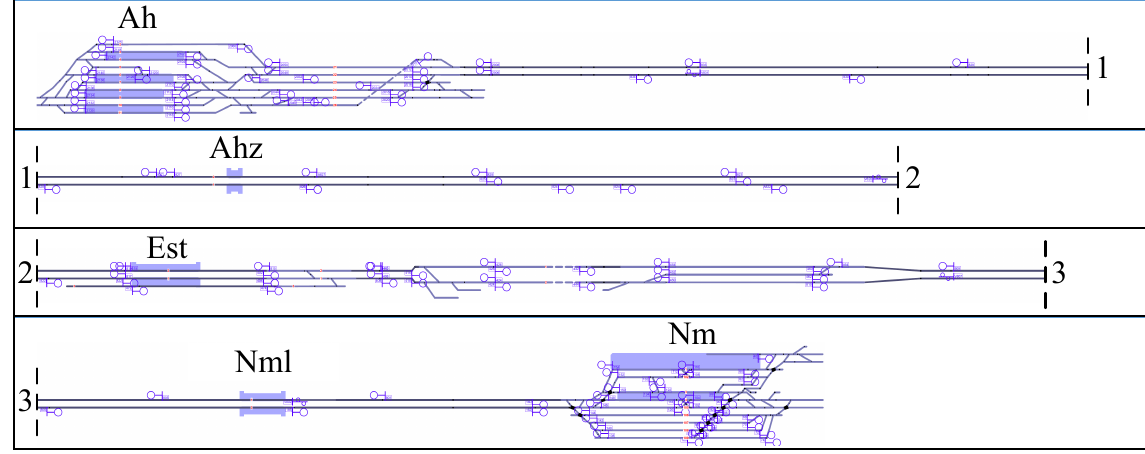
Figure 3: Detailed track layout of railway line Arnhem Central (Ah)–Nijmegen (Nm). phases: one before and one after the reduced speed limit of 130 km/h after Est with possibly a short distance of maximum acceleration after the reduced speed limit of 130 km/h before